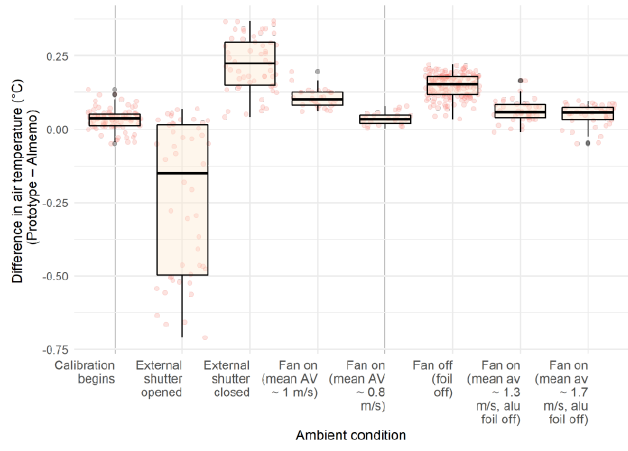
Figure A1. Air temperature recorded by the Arduino prototype and Almemo instrument during various ambient conditions.